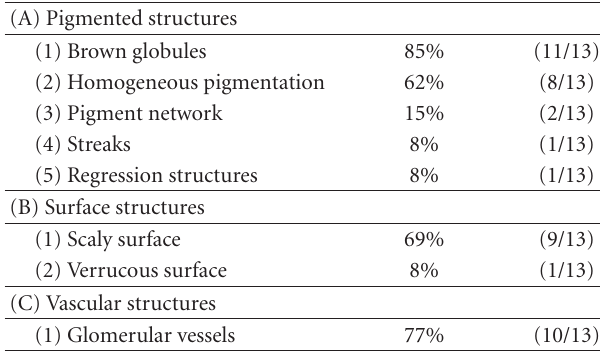
Table 1: Summary of previously reported dermoscopic features for pigmented BD